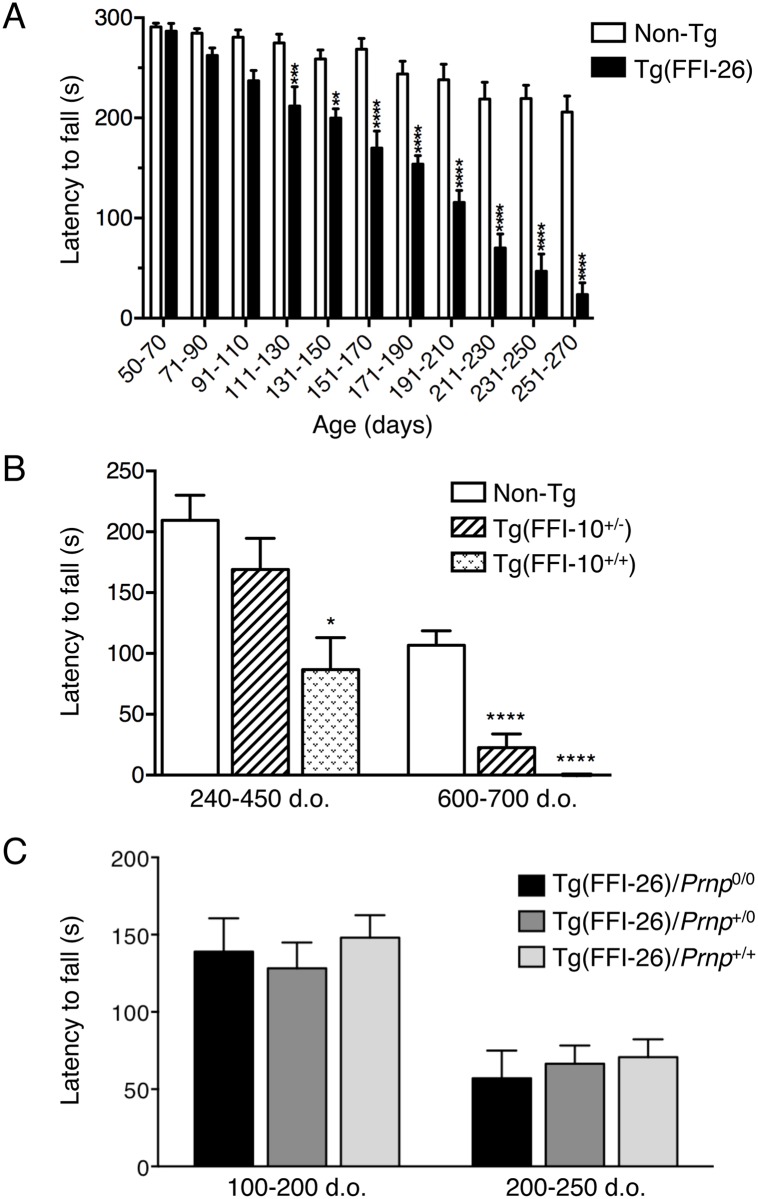
Tg(FFI) mice develop motor dysfunction which is not rescued by co-expression of wild-type PrP.(A) Groups of 7–12 Tg(FFI-26+/-)/Prnp
0/0 and 9–13 non-Tg/Prnp
0/0 littermates were tested on a Rotarod at the ages indicated. Each mouse was tested three times, and the mean latency to fall was calculated. Bars indicate the mean ± SEM of latency to fall (s); F10,192 = 10.82, p < 0.0001 by two-way ANOVA; **p < 0.01 and ****p < 0.0001 Šidàk’s post hoc test. (B) Groups of 6–19 (240–450 days old) and 10–11 (600–700 days old) Tg(FFI-10+/-)/Prnp
0/0, Tg(FFI-10+/+)/Prnp
0/0 and non-Tg/Prnp
0/0 littermates were tested on a Rotarod. Bars indicate the mean ± SEM of latency to fall (s); F2,28 = 34.05, p < 0.0001 by one-way ANOVA; *p < 0.05 and ****p < 0.0001 vs. non-Tg; Tukey’s post hoc test. (C) Groups of 9 Tg(FFI-26+/-)/Prnp
0/0, 10 Tg(FFI-26+/-)/Prnp
+/0, and 8 Tg(FFI-26+/-)/Prnp
+/+ littermates were tested on a Rotarod and the ages indicated. F2,45 = 0.3374; p = 0.7154 by two-way ANOVA.